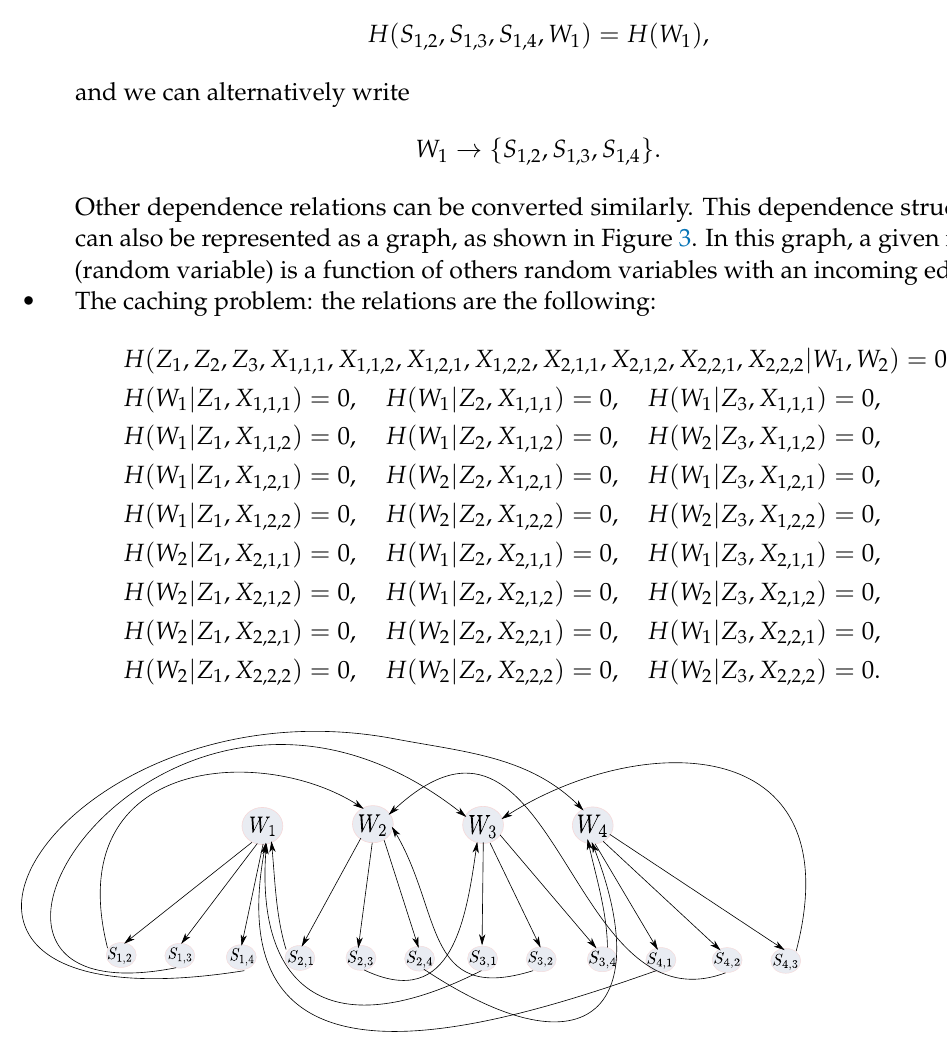
Figure 3. A graph representation for dependence relation in the regenerating code problem with ( n , k , d ) = ( 4,3,3 )